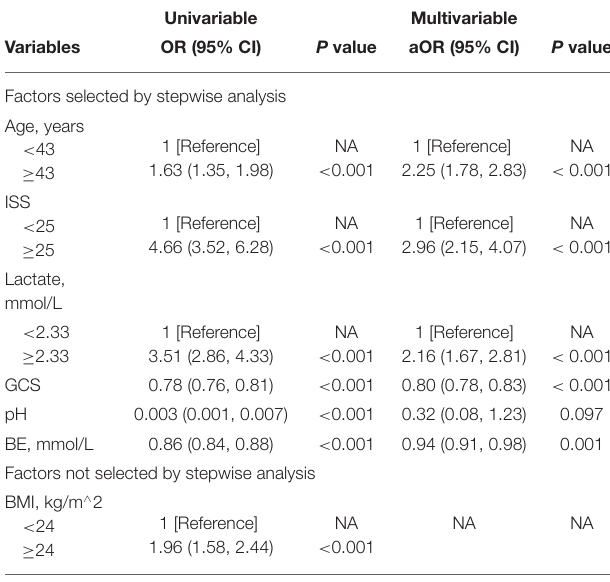
TABLE 3 | Comparisons between patients who survived and deceased patients across all post-conversion variables in the training cohort.